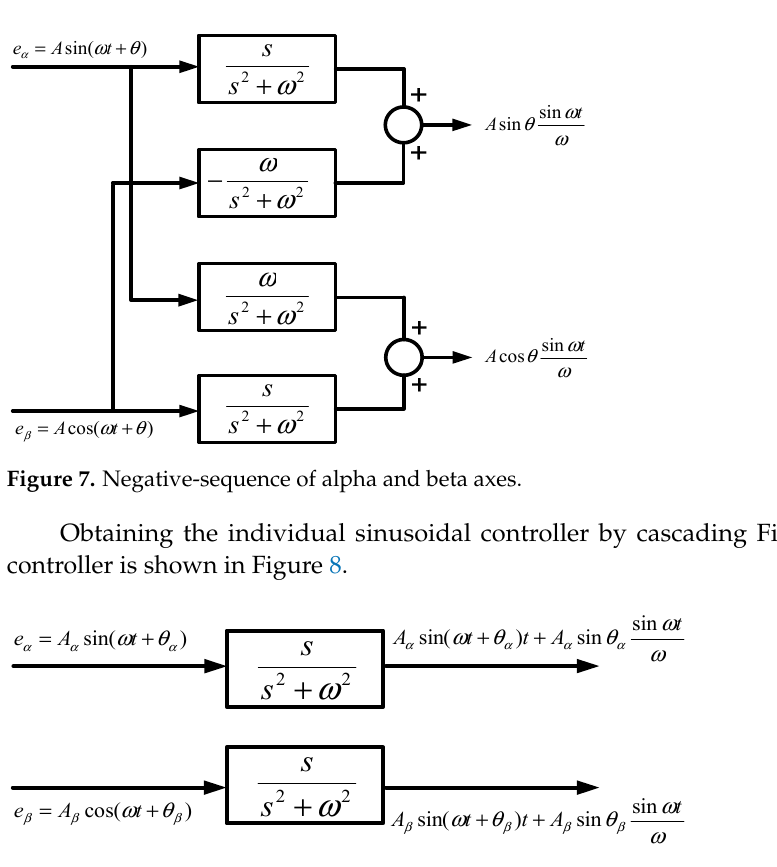
ref I Figure 10. PR controller to neutralize the fifth order harmonic component.